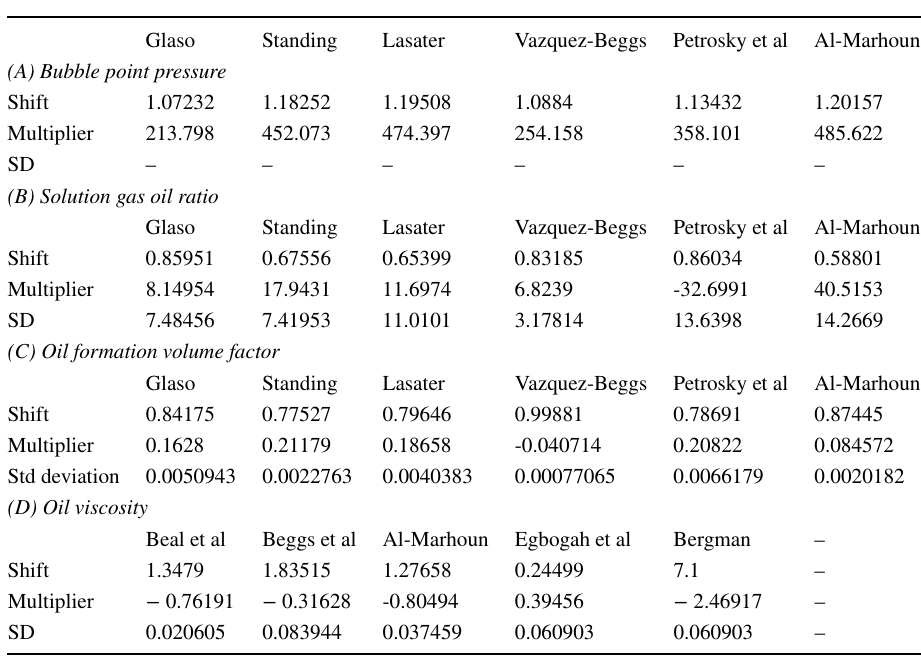
Table 3 The shift, multiplier, and standard deviation parameters derived from PVT matching of laboratory data with empirical relationships for four parameters: (A) bubble point pressure, (B)